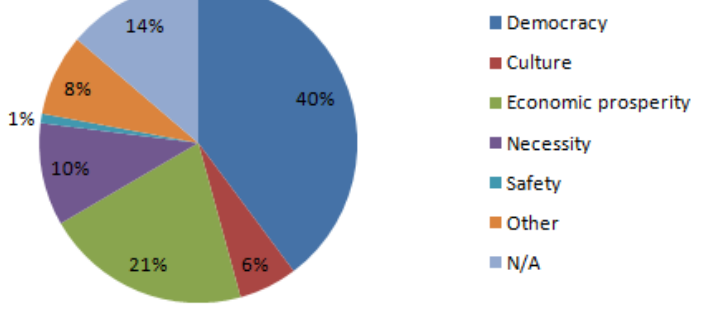
Figure 5. Justifications of EU polity worth. Table 2. EU polity contestation and justifications (Greek crisis). Types of Evaluation